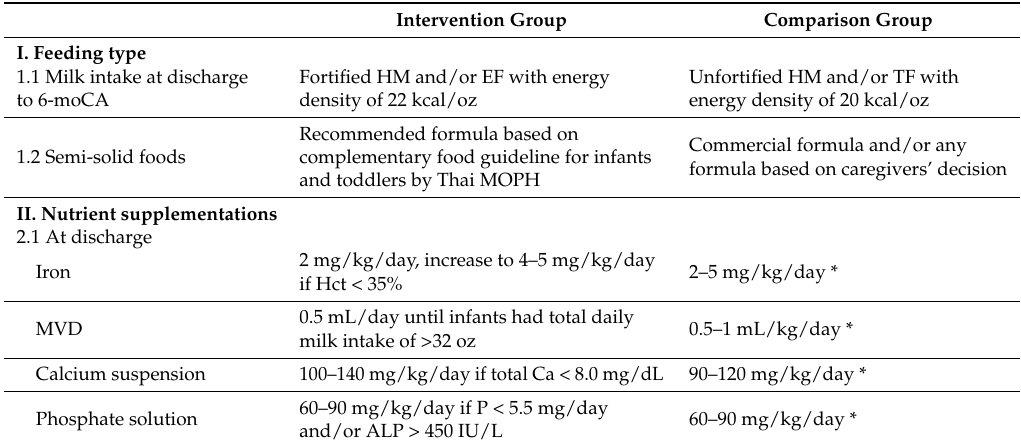
Table 3. Comparisons of feeding type and nutrient supplementations for preterm infants after discharge between the intervention and comparison